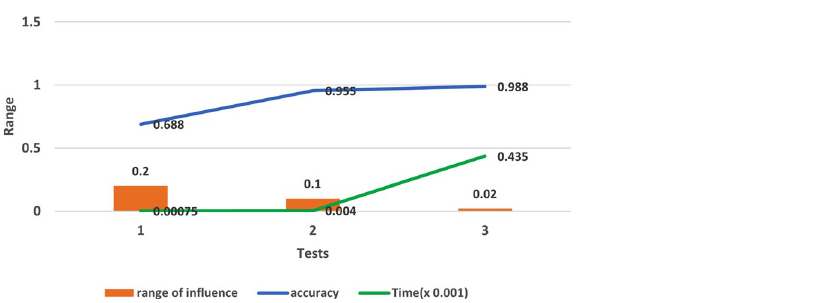
Figure 3. Sample of the dataset. The first row shows sample of COVID-19 cases and the second row shows the normal cases.